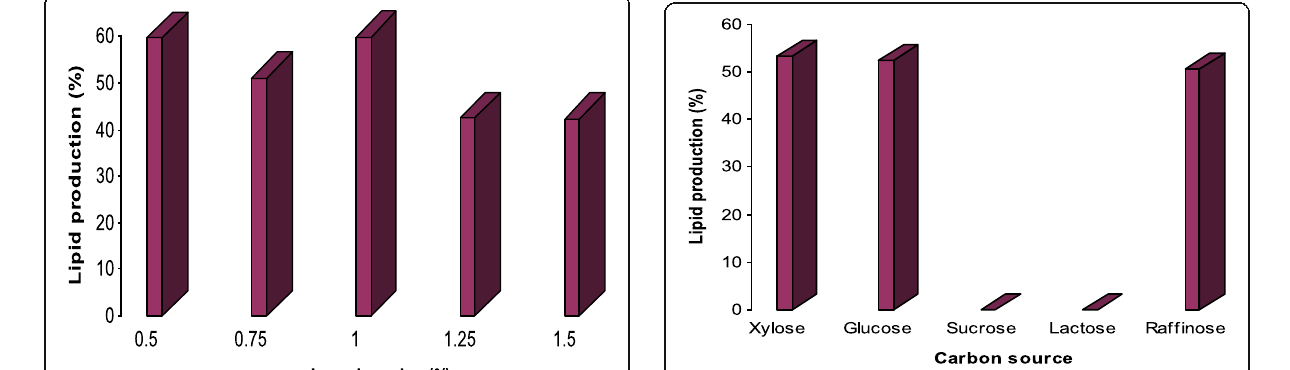
Fig. 8 Effect of different carbon sources on F. oxysporum NRC 2017 lipid